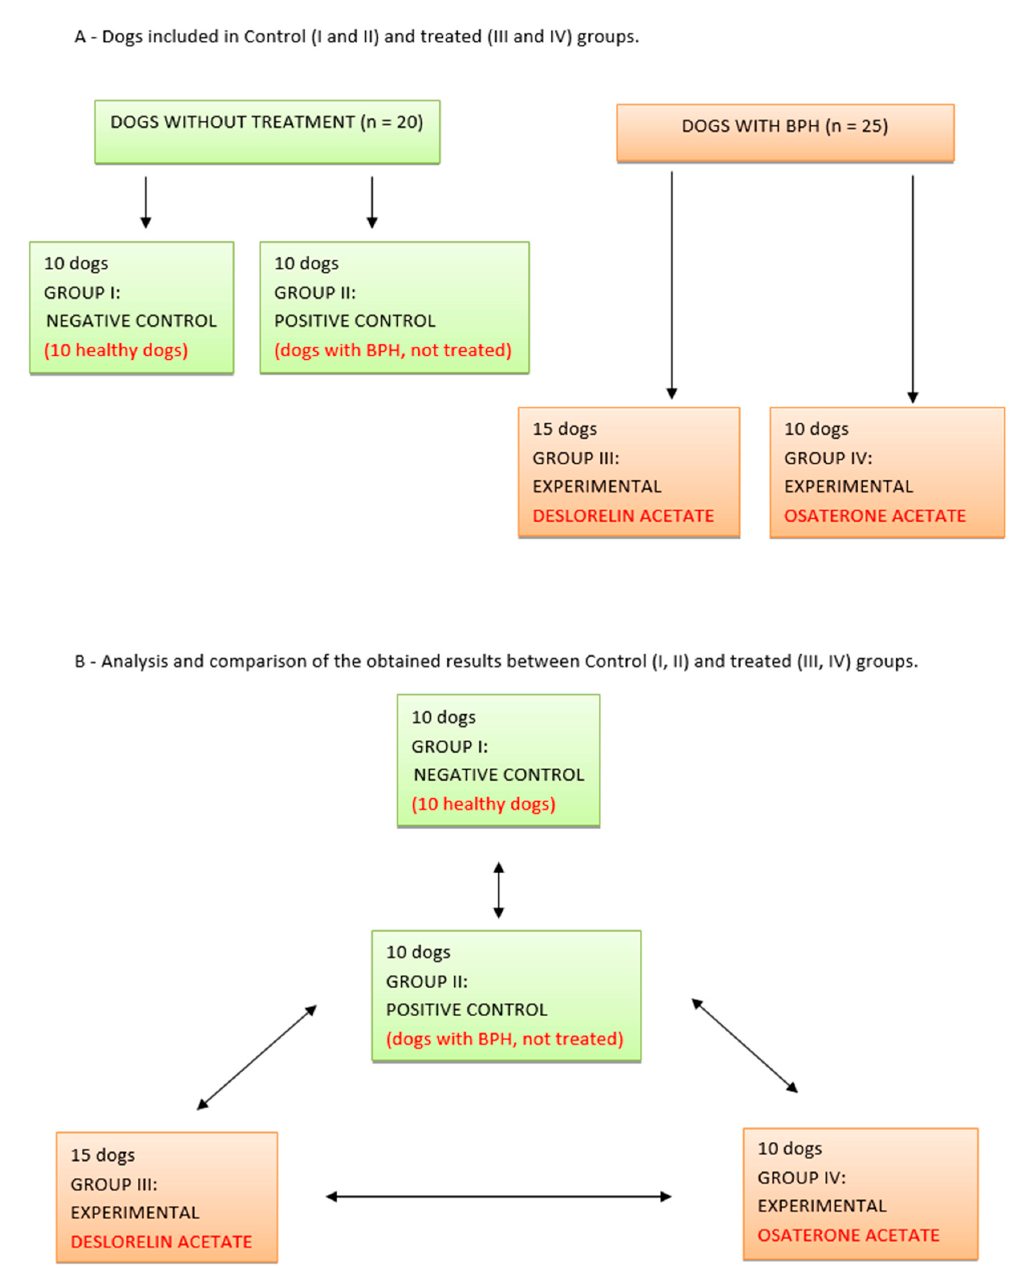
Figure 1. Study design (BPH—benign prostate hyperplasia).